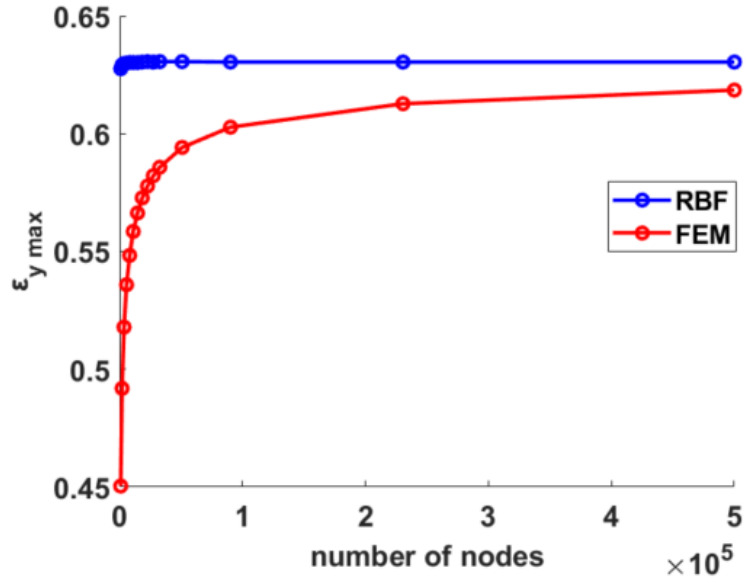
Figure 6. Convergence trends for the RBF post-processing method (blue) and FEM (red).